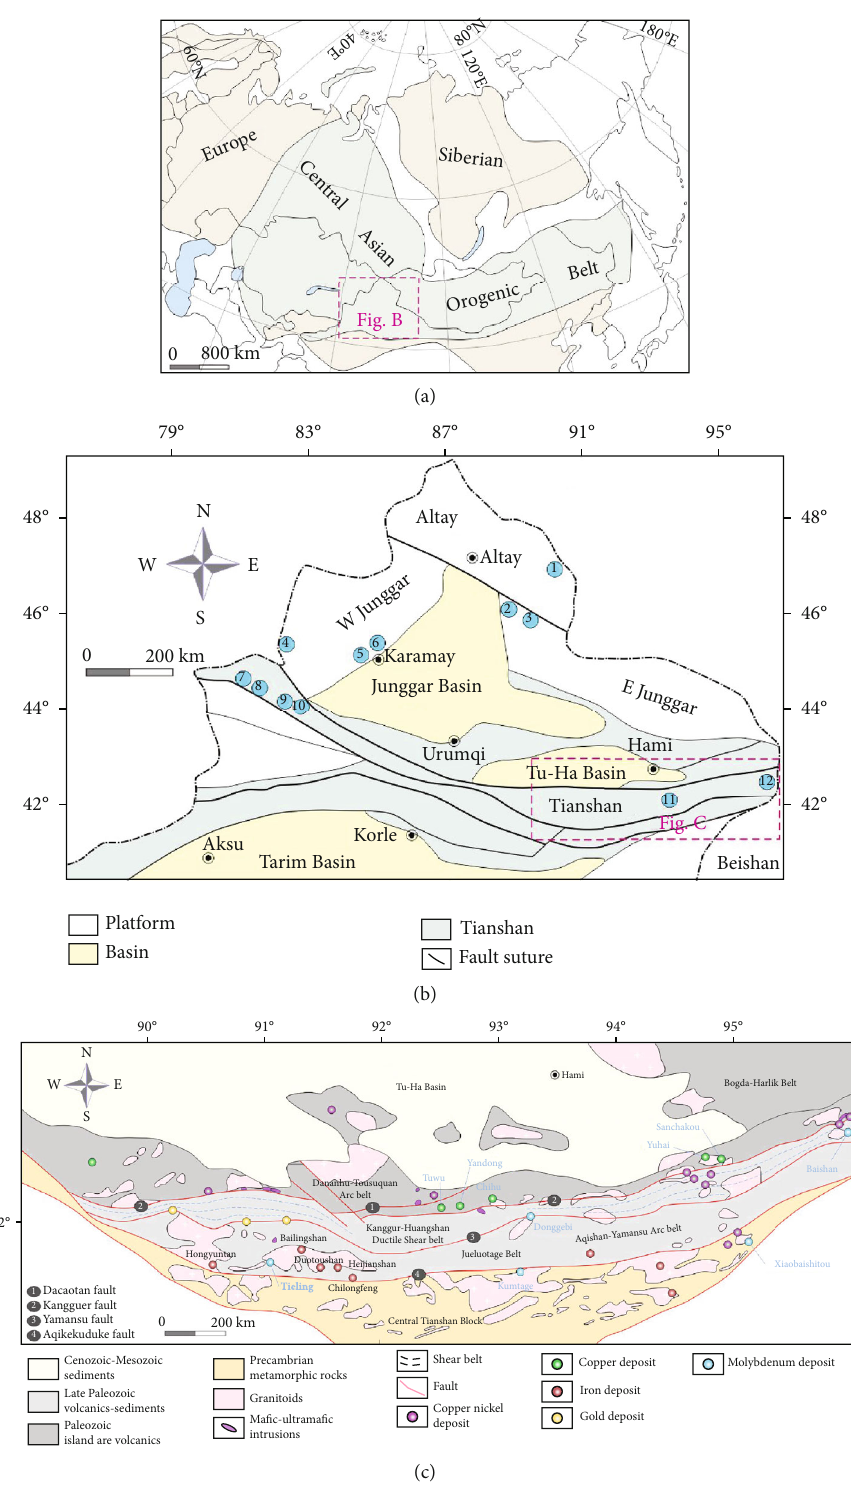
Figure 1: (a) Simpli fi ed map of the CAOB; (b) tectonic framework and representative deposits in northern Xinjiang; (c) simpli fi ed geological map of the eastern Tianshan showing the distribution of representative deposits (modi fi ed from Wang et al. [16]). 1: Asikaerte; 2: Suoerkuduke; 3: Yulekenhalasu; 4: Suyunhe; 5: Baogutu; 6: Hongyuan; 7: Dabate; 8: Kekesai; 9: Lailisigaoer;